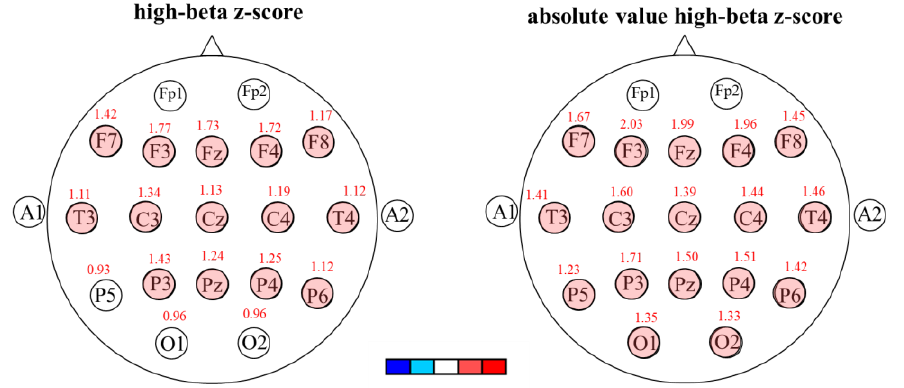
Figure 3. The high-beta z-scores ( left ) and high-beta absolute value z-scores ( right ) in the MDD group. Table 4. The z-scores and absolute value z-scores in the MDD group.